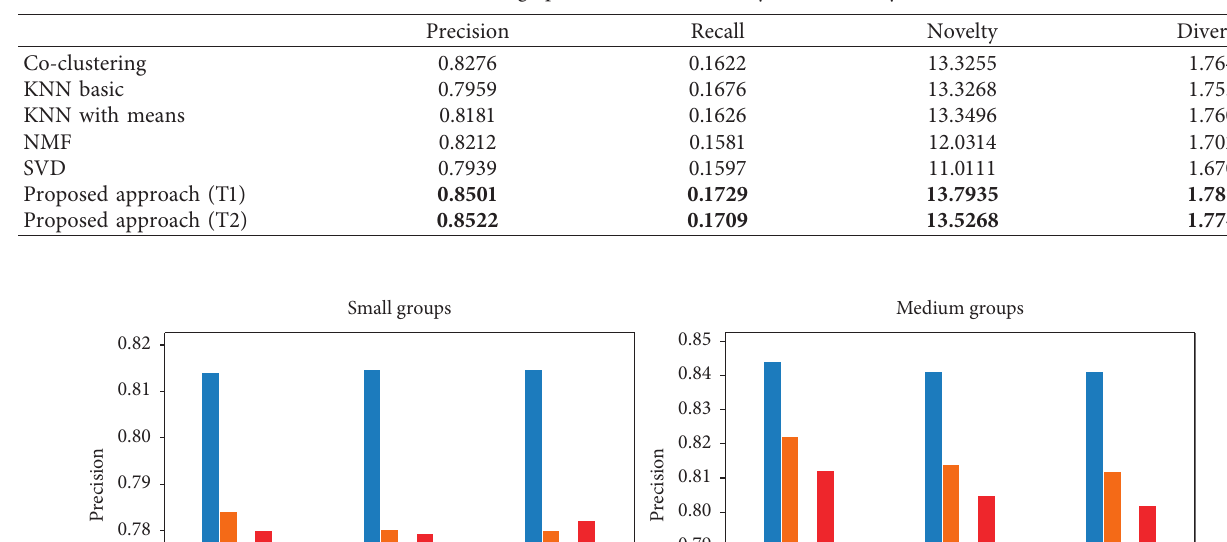
Table 5: Average precision, recall, novelty, and